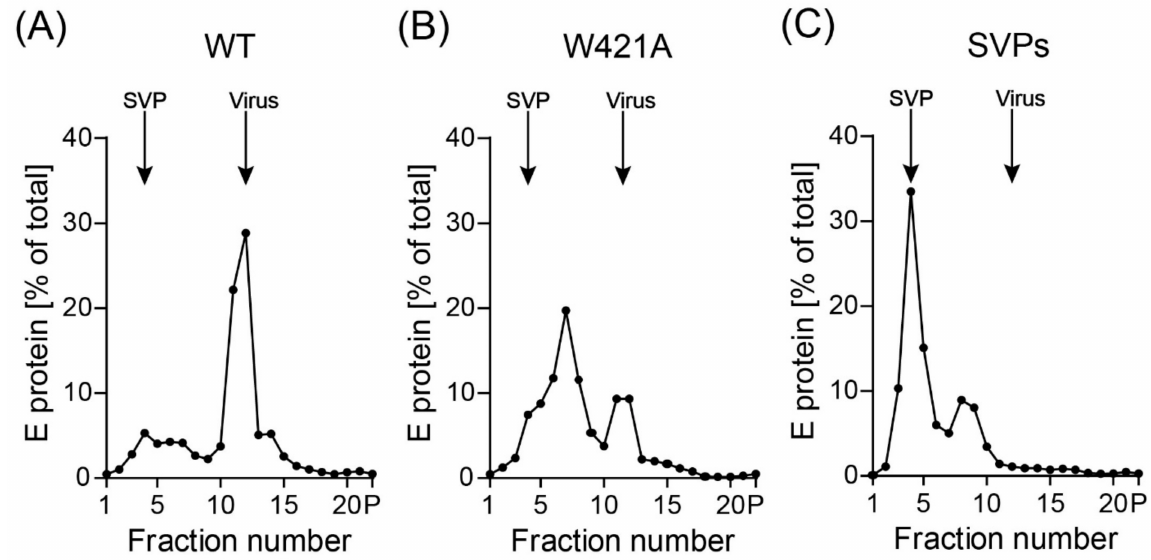
Figure 4. Rate zonal centrifugation of WT and mutant particles. Resuspended pellets (Figure 2C) containing viral as well as subviral particles (SVPs) were subjected to sedimentation analysis using continuous sucrose density gradients. The amount of E protein in each fraction was determined by ELISA. Sedimentation is from left to right. Representative examples out of two independent experiments are shown. The positions of SVPs and virions are indicated. ( A ) wildtype (WT), ( B ) W421A mutant, ( C )